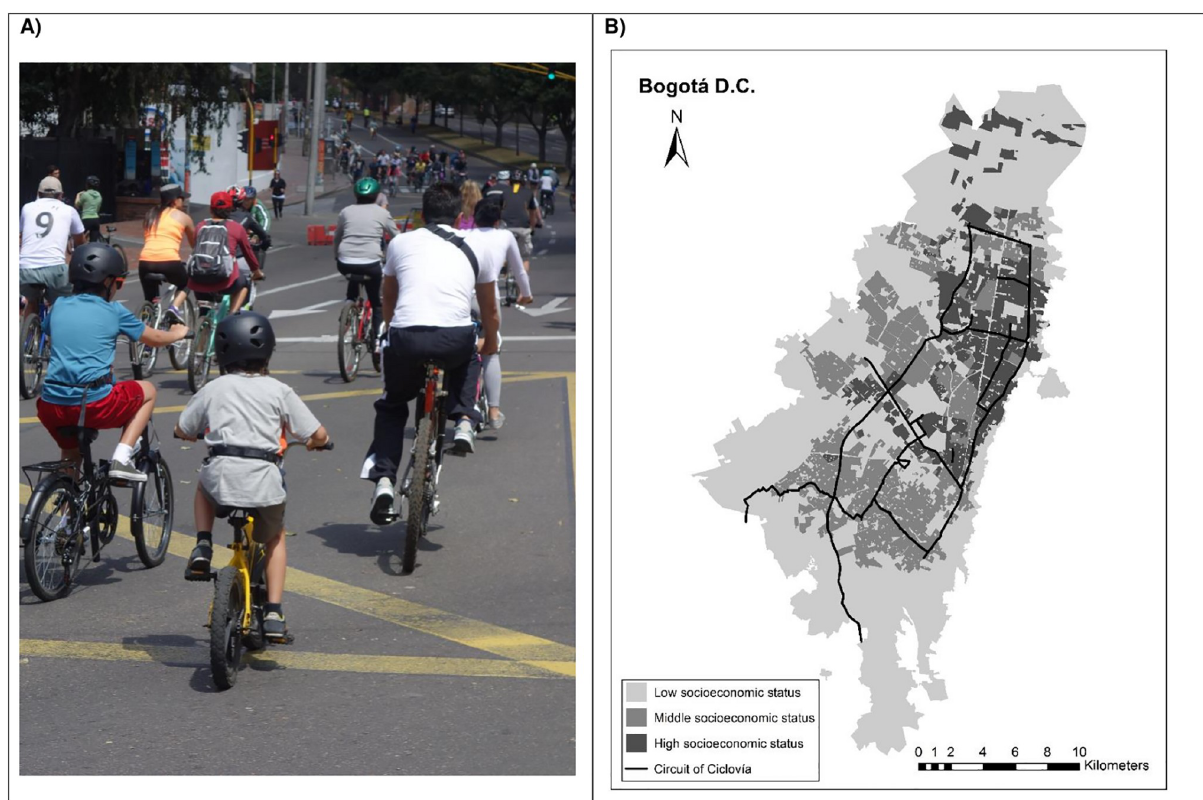
Fig 1. Ciclovı´a program of Bogota´. A) Photograph of the Ciclovı´a program with participation of children and their families. Photograph by Olga L. Sarmiento. B) Circuit of the Ciclovı´a of Bogota´ crossing neighborhoods with different socioeconomic statuses. Image created by authors.